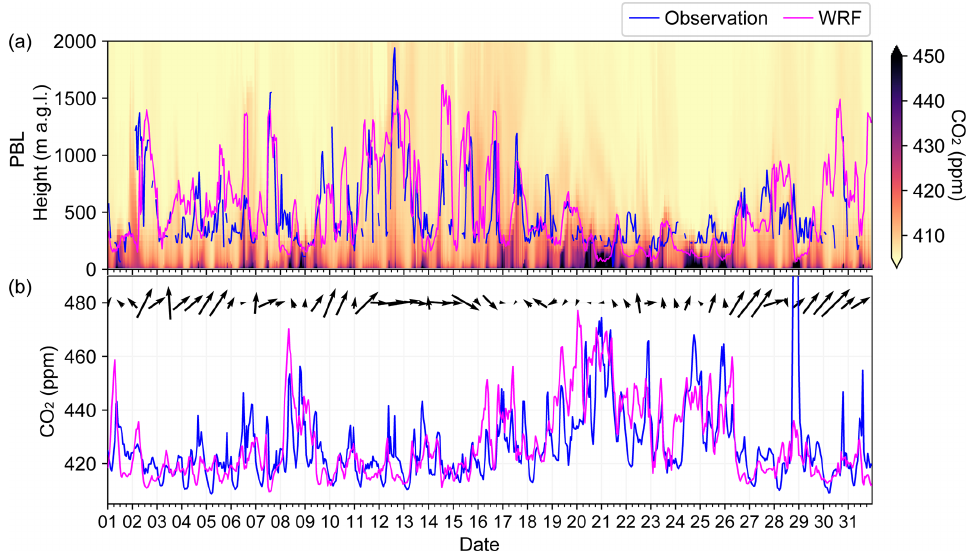
Figure 8. (a) Vertical distribution of CO 2 concentrations at CDS station for January 2016, together with time series of the observed and BEP_MYJ simulated PBL heights at SIRTA station. (b) Time series of the observed and simulated CO 2 concentration at CDS. The arrows on the top of the figure indicate the wind speed and direction every day at noon and midnight. The simulation uses the AirParif CO 2 emission inventory.